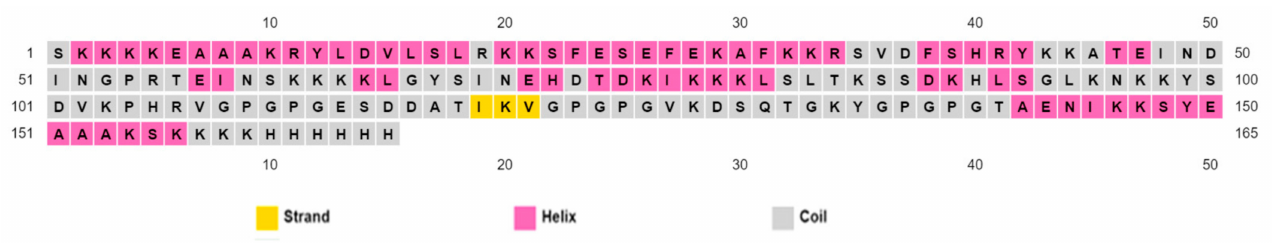
Figure 3. Secondary folding of the proposed chimera as projected by the PSIPRED